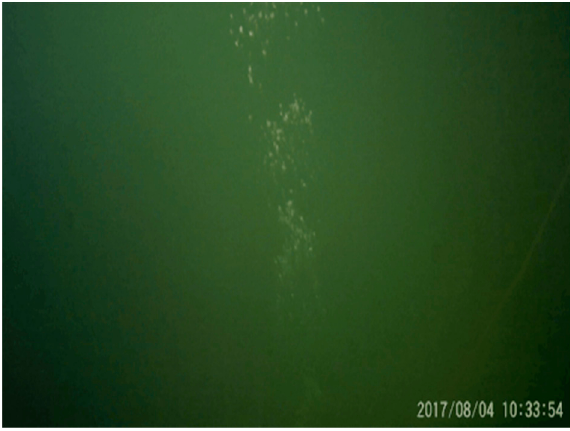
Figure 5. An underwater video screenshot of the bubbles being released.